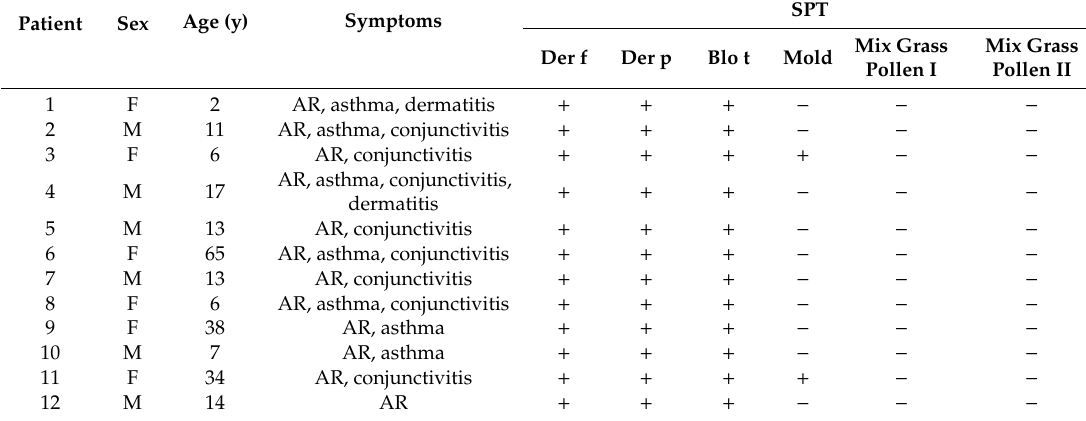
y, year; Der f, Dermatophagoides farinae ; Der p, Dermatophagoides pteronyssinus ; Blo t, Blomia tropicalis ; AR, allergic rhinitis; SPT, skin prick test; + positive ( ≥ 3 × 3 mm); − negative ( < 3 × 3 mm).